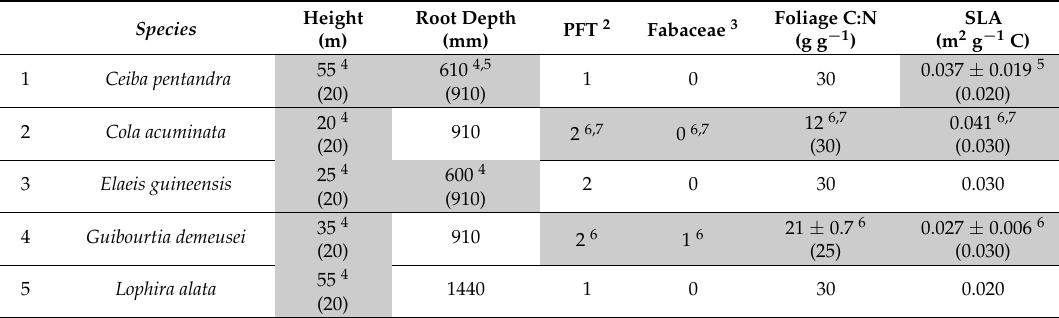
Table 2. The selected species and the morpho-physiological traits for which some values were refined. Grey cells are species-specific values while white cells indicate initial plant functional type (PFT) values. The trait variations (standard deviation) for the foliage carbon/nitrogen ratio (C:N) and the specific leaf area (SLA) are given in addition to the mean value when the number of data is large enough. When species-specific trait data were found, the previous PFT values (standard in CARAIB 1 ) are noted between